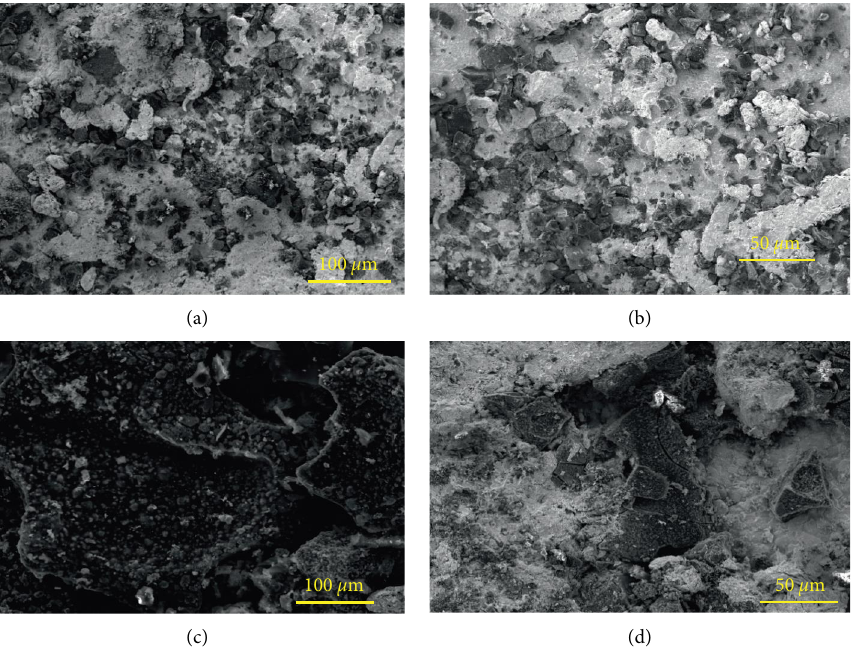
Figure 3: (a) Composite with distribution of SiC, (b) Contact point of base matrix specimen with SiC, (c) Tempered composite with the distribution of SiC,(d) Contact point of the tempered composite specimen with SiC.